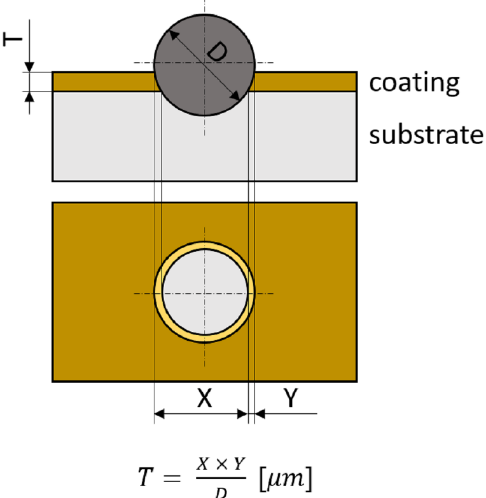
Figure 2: The principle of the calotest method (based on [6]); D – the diameter of the ball used in the test, X and Y – diameters of the obtained scar, T – coating thickness.